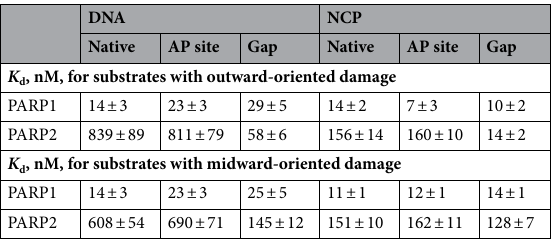
Table 1. The affinity of PARP1 and PARP2 for native, AP site–containing or gap-containing substrates as determined by fluorescence anisotropy